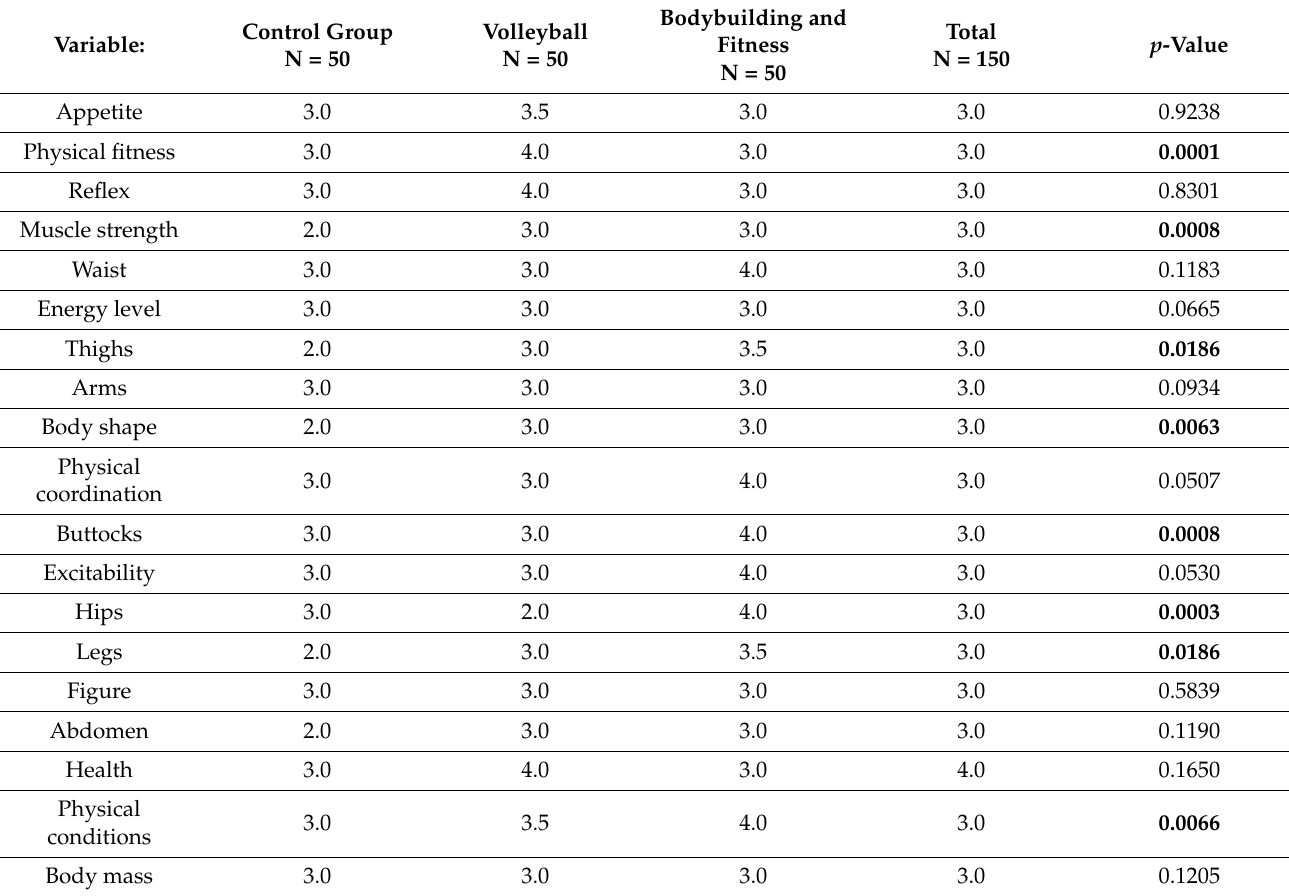
Table 4. Evaluation of self-image of the Body Evaluation Scale BES in the studied groups of women (median). Bold values represent statistical